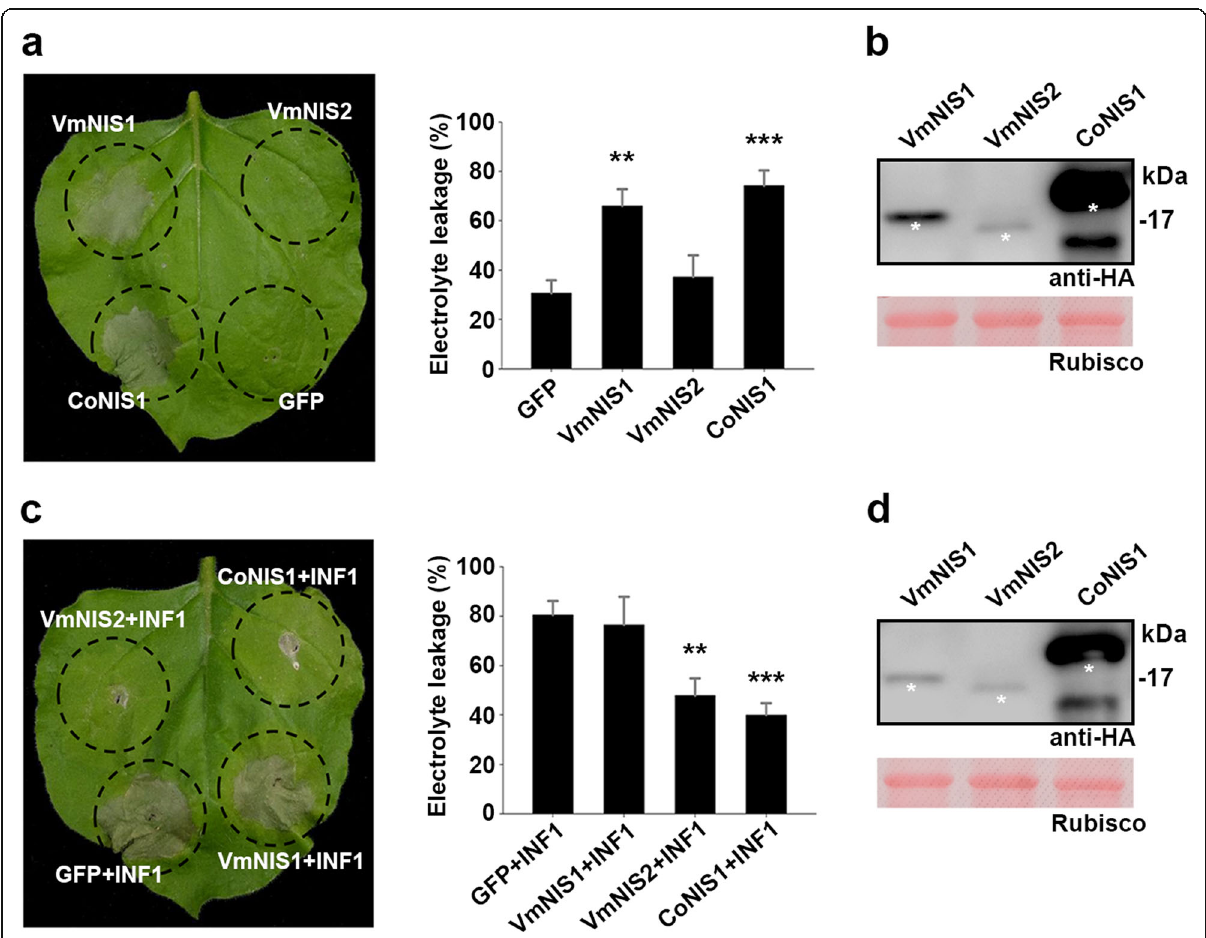
Fig. 2 VmNIS1 induces cell death and VmNIS2 suppresses cell death in N. benthamiana . a. Representative leaves showing cell death induced by VmNIS1 in N. benthamiana . VmNIS1, VmNIS2, CoNIS1 and GFP were transiently expressed in N. benthamiana by agroinfiltration. Photographs were taken 4 days post agroinfiltration (dpa). Cell death was quantified by measuring electrolyte leakage. Values represent the means ± SD of three independent biological replicates. Differences were assessed by Student ’ s t -test. **, P < 0.01; ***, P < 0.001. b. Western blotting detection of VmNIS1 and VmNIS2 expressed in N. benthamiana leaves with anti-HA antibody. Ponceau S-stained Rubisco protein was shown as a loading control. The bans with expected size were indicated by white asterisks. c. Representative leaves showing VmNIS2 suppressed INF1-triggered cell death in N. benthamiana . VmNIS1, VmNIS2, CoNIS1 and GFP were transiently expressed in N. benthamiana leaves by agroinfiltration, and INF1 was agroinfiltrated in the same injection sites 24 h later. Photographs were taken 3 dpa of INF1.Cell death was quantified by measurement of electrolyte leakage. Values represent the means ± SD of three independent biological replicates. Differences were assessed by Student ’ s t -test. **, P < 0.01; ***, P < 0.001. d. Western blotting detection of VmNIS1 and VmNIS2 that co-expressed with INF1 in N. benthamiana leaves with anti-HA antibody. Ponceau S-stained Rubisco protein was shown as a loading control. The bans with expected size were indicated by white